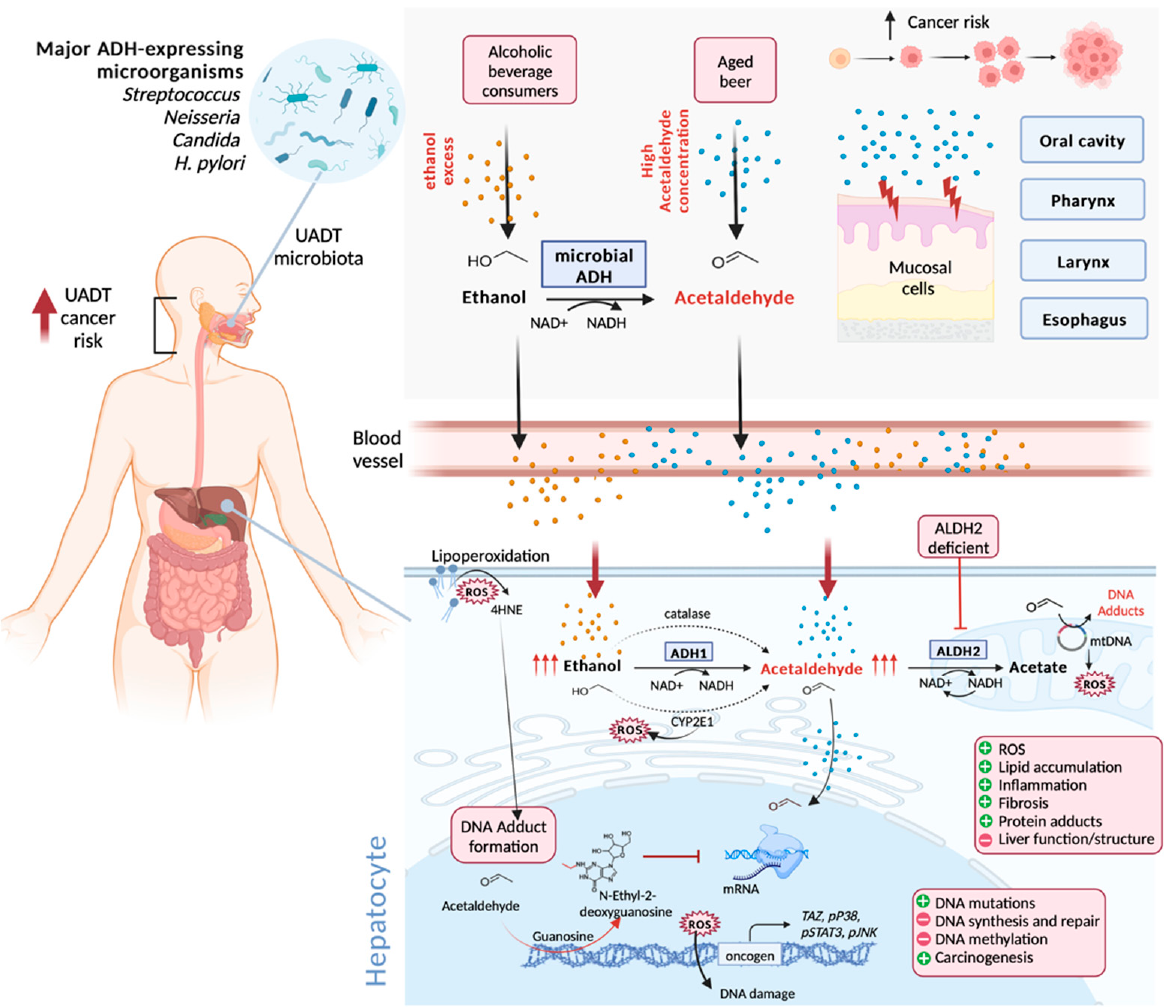
Figure 3. Molecular mechanisms of acetaldehyde-induced pathogenesis. Ingested ethanol is metabolized mainly in the liver (bottom panel) with the conversion of alcohol to acetaldehyde by alcohol dehydrogenase (ADH1), catalase, and CYP2E1, with the release of reactive oxygen species (ROS). Before reaching the liver through blood vessels, a small portion of the ingested alcohol is metabolized in the upper aerodigestive tract (UADT) (upper panel) by microbial ADH, especially from Streptococcus , Neisseria , and Candida genus, and H. pylori , which comprise the UADT microbiota. Acetaldehyde detoxification takes place in the liver with acetate generation from acetaldehyde into mitochondria due to aldehyde dehydrogenase (ALDH2) activity, which is absent in the UADT. In the human body, exposure can be enhanced by additional acetaldehyde influxes outside alcohol metabolism from aged beer and other dietary sources, contributing to acetaldehyde accumulation, which can be exacerbated by the ALDH2 polymorphism or its absence. Acetaldehyde reacts with DNA and proteins, forming mutagenic and toxic adducts, such as N-ethyl-2-deoxyguanosine. The accumulation of ROS gives rise to DNA damage and lipoperoxidation stimulation, with the release of mutagenic 4HNE, which also forms DNA adducts. DNA adducts, in turn, block DNA translesion and transcription, triggering DNA point mutations, impairing DNA methylation and activating oncogenic pathways, including TAZ, pP38, pSTAT3, and pJNK. These events culminate in liver damage, compromising hepatic tissue function and structure by protein adducts, inflammatory reaction, fibrosis, and lipid accumulation, leading to liver-related pathology development, hepatocellular carcinoma, and UADT cancer. The figure was created with